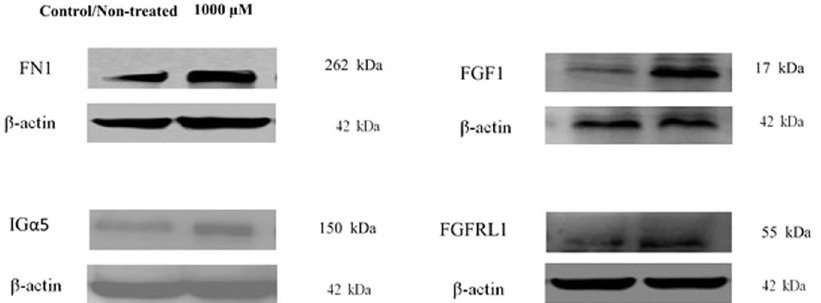
Fig. 5 Western blot analyses. FN1, FGF1, FGFRL1, and Itg α 5 proteins for control (non-treated) and 1000 μ M of ASA treatments in osteogenic differentiation of PDLSCs ( n =